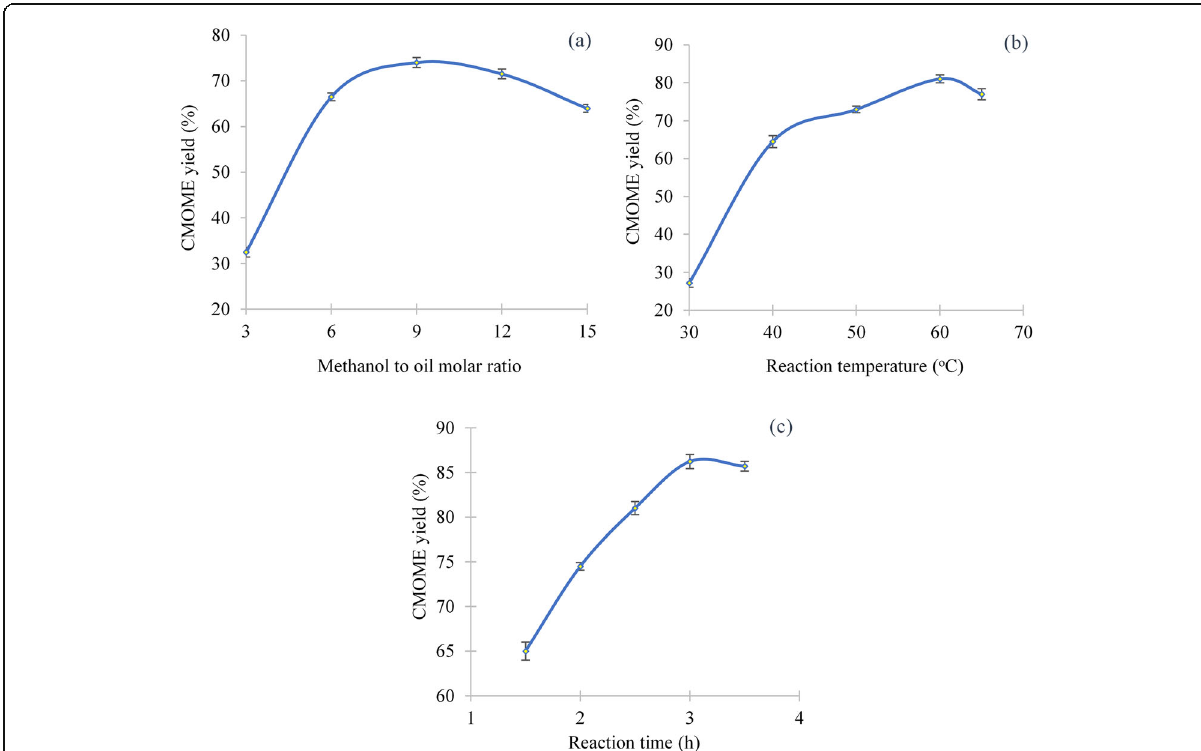
Fig. 5 Effects of: methanol to oil ratio ( a ), reaction temperature ( b ), and reaction time ( c ), on CMOME yield, with absolute error bars resulting from duplicated